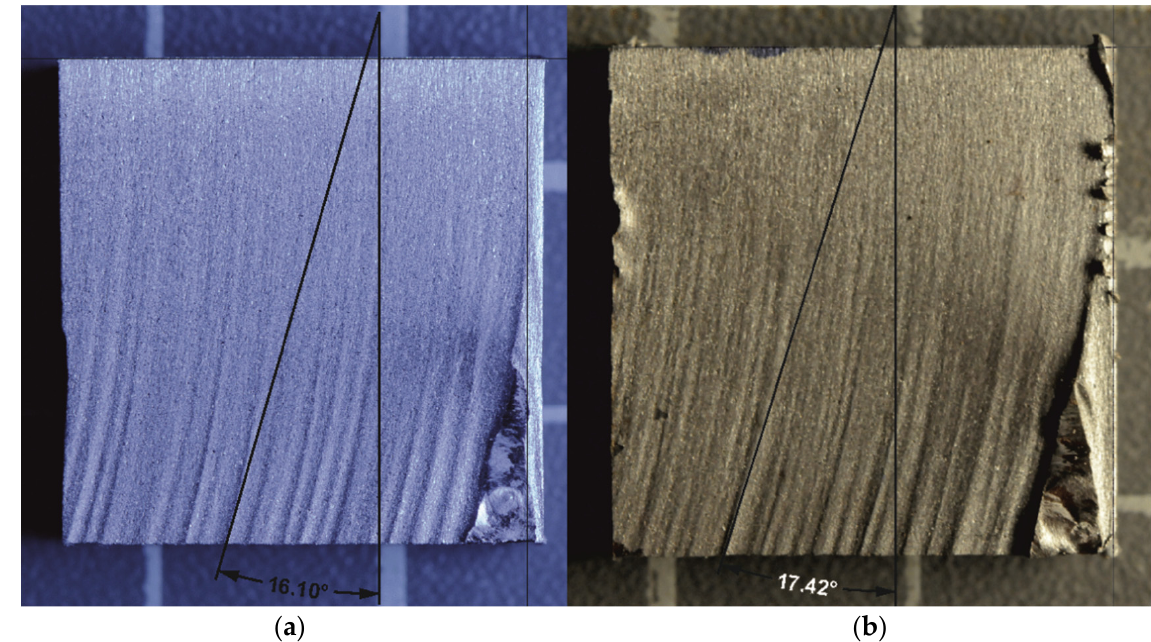
Figure 1. The declination angle measurement for titanium samples with traverse speed of 60 mm/min ( a ) and 75 mm/min ( b ).